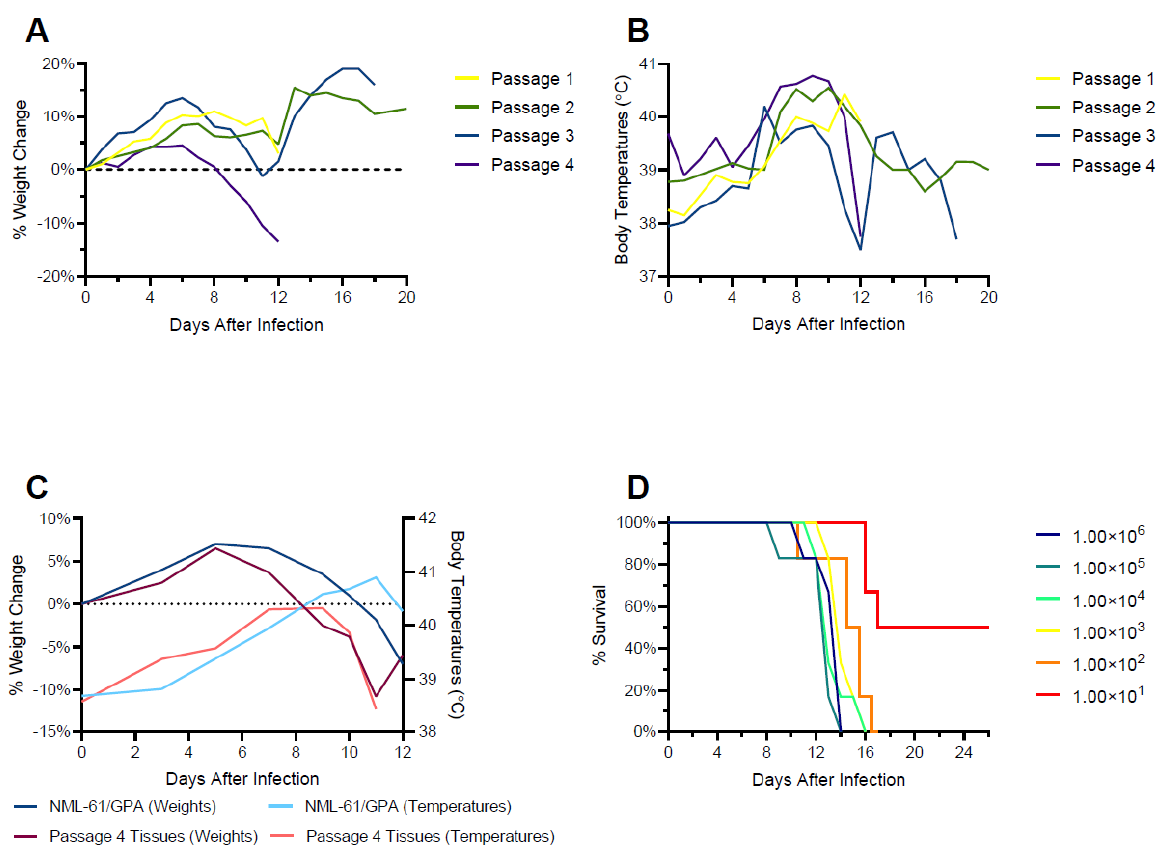
Figure 2. Guinea pig adaption of a clade III Nigerian Lassa virus isolate. Groups of 4 Hartley guinea